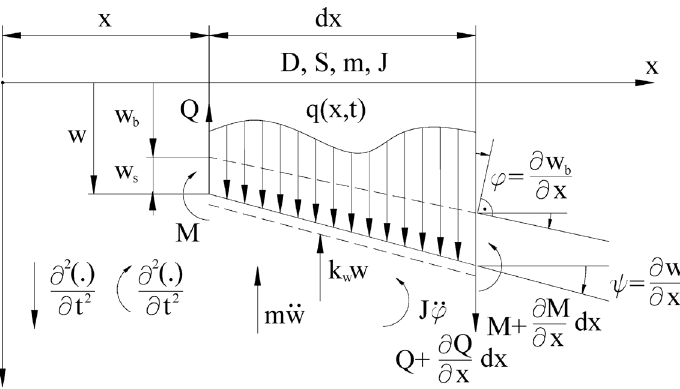
Figure 1 Displacements and forces on differential element of a beam on elastic